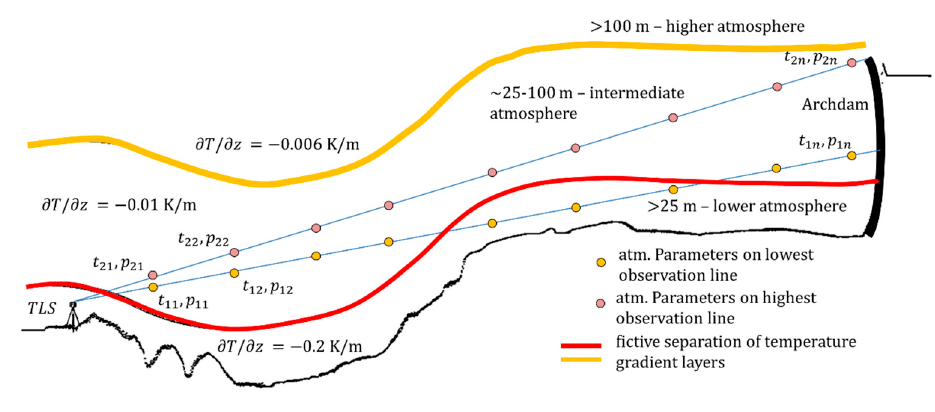
Figure 5. Vertical section through the terrain and temperature gradient fictive separation.